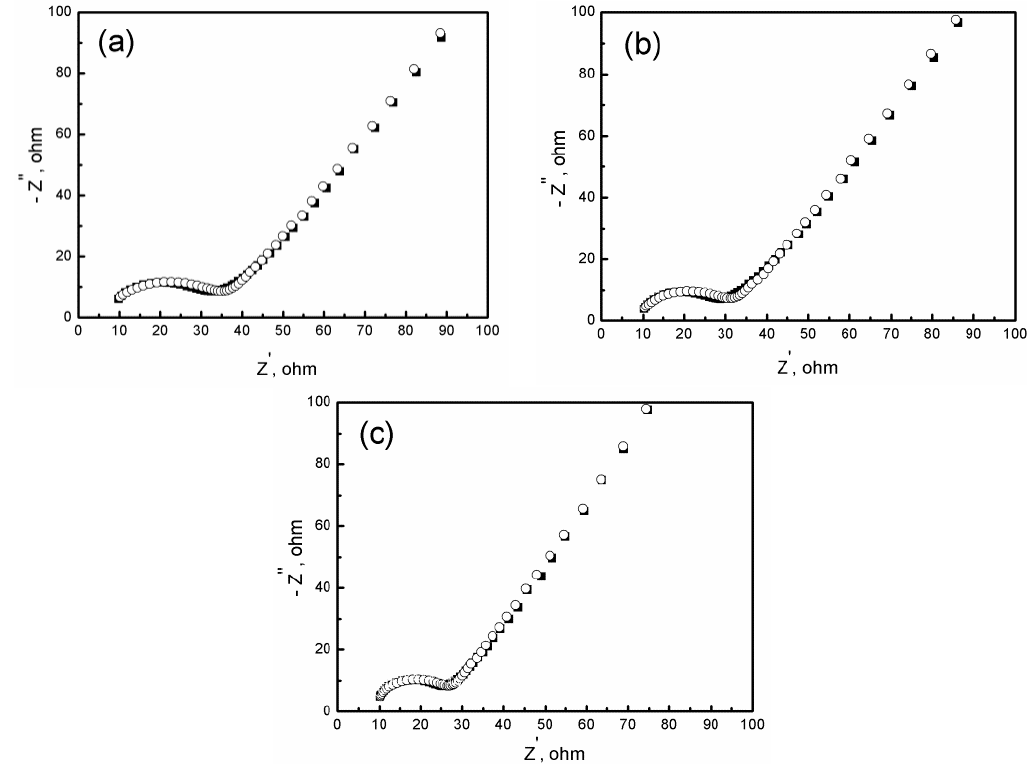
Figure 8. Nyquist diagrams for CaP coating on SLM-Ti scaffolds at deposition time of ( a ) 6000 s, ( b ) 3000 s, and ( c ) 1000 s. ■■■ : experimental data and ○○○ : fitting result.